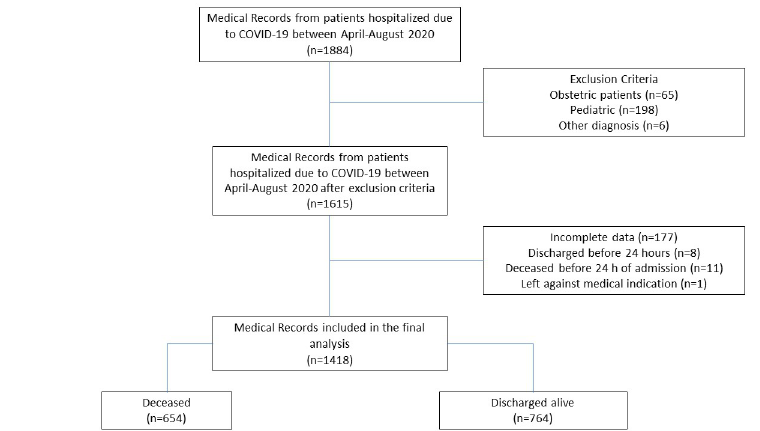
Fig 1. Flow chart of patients included in the study. Hospital Nacional Hipolito Unanue. April to August 2020. Lima, Peru.